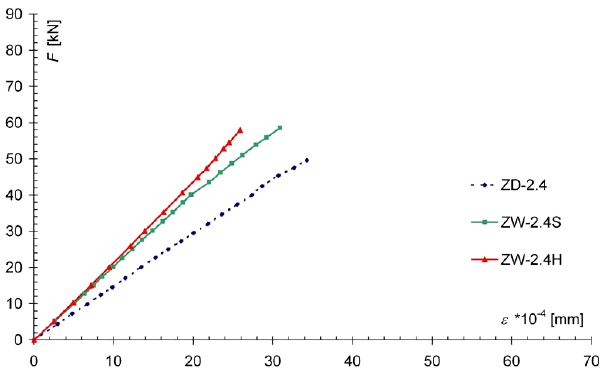
Figure 11. Graph of F- ε dependence for stretched marginal wood fibers in the center of the model span, showing average values.